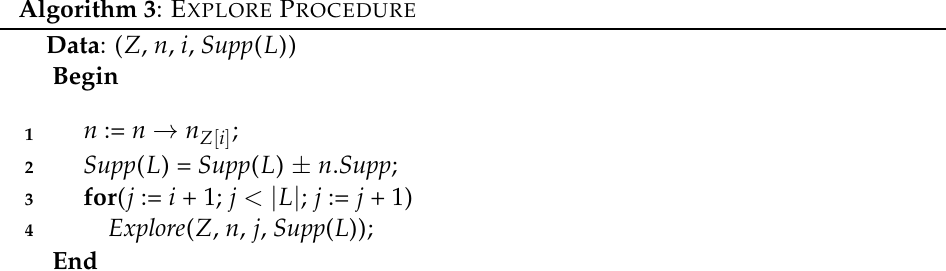
Algorithm 3 : E XPLORE P ROCEDURE